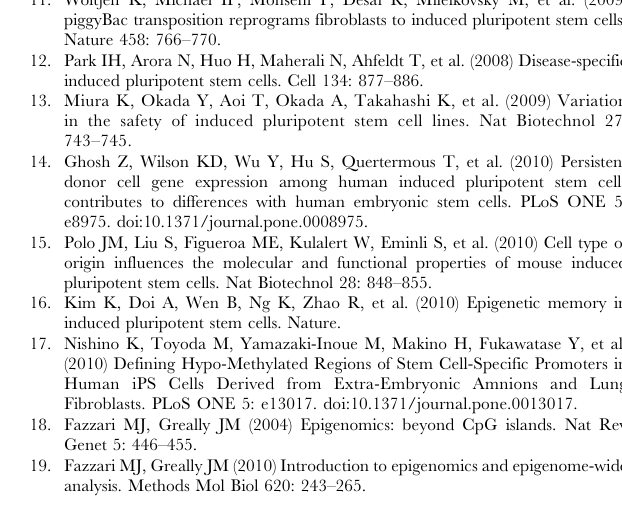
Table S1 List of human cells analyzed for a methylation state in this study. Table S2 STR analysis of iPSCs. Table S3 Karyotypic analysis of iPSCs. Table S4 List of genes with stem cell-specific DMRs exhibiting significant changes in expression in human iPS cells. Table S5 List of the top 100 genes with hypo-methylated stem cell-required DMRs exhibiting ‘high’ expression in human iPS cells. Table S6 List of top 100 genes with hyper-methylated stem cell- required DMRs exhibiting suppression in human iPS cells. Table S7 List of top 5 categories of GO Term in ‘‘Stem cell- required DMRs’’. Table S8 Primer